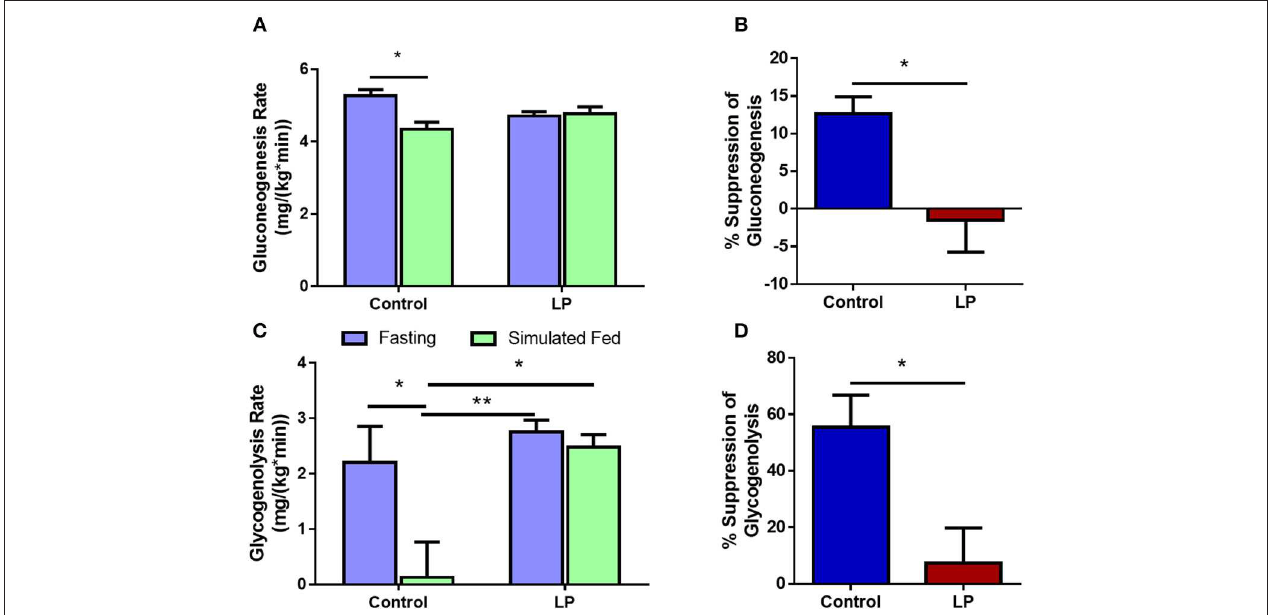
FIGURE 5 | Hepatic glucose production in females via gluconeogenesis (A,B) and glycogenolysis (C,D) by control and type 2 diabetic (LP) rats during fasting and simulated fed states. * p < 0.05 and ** p < 0.01, n = 5–6.